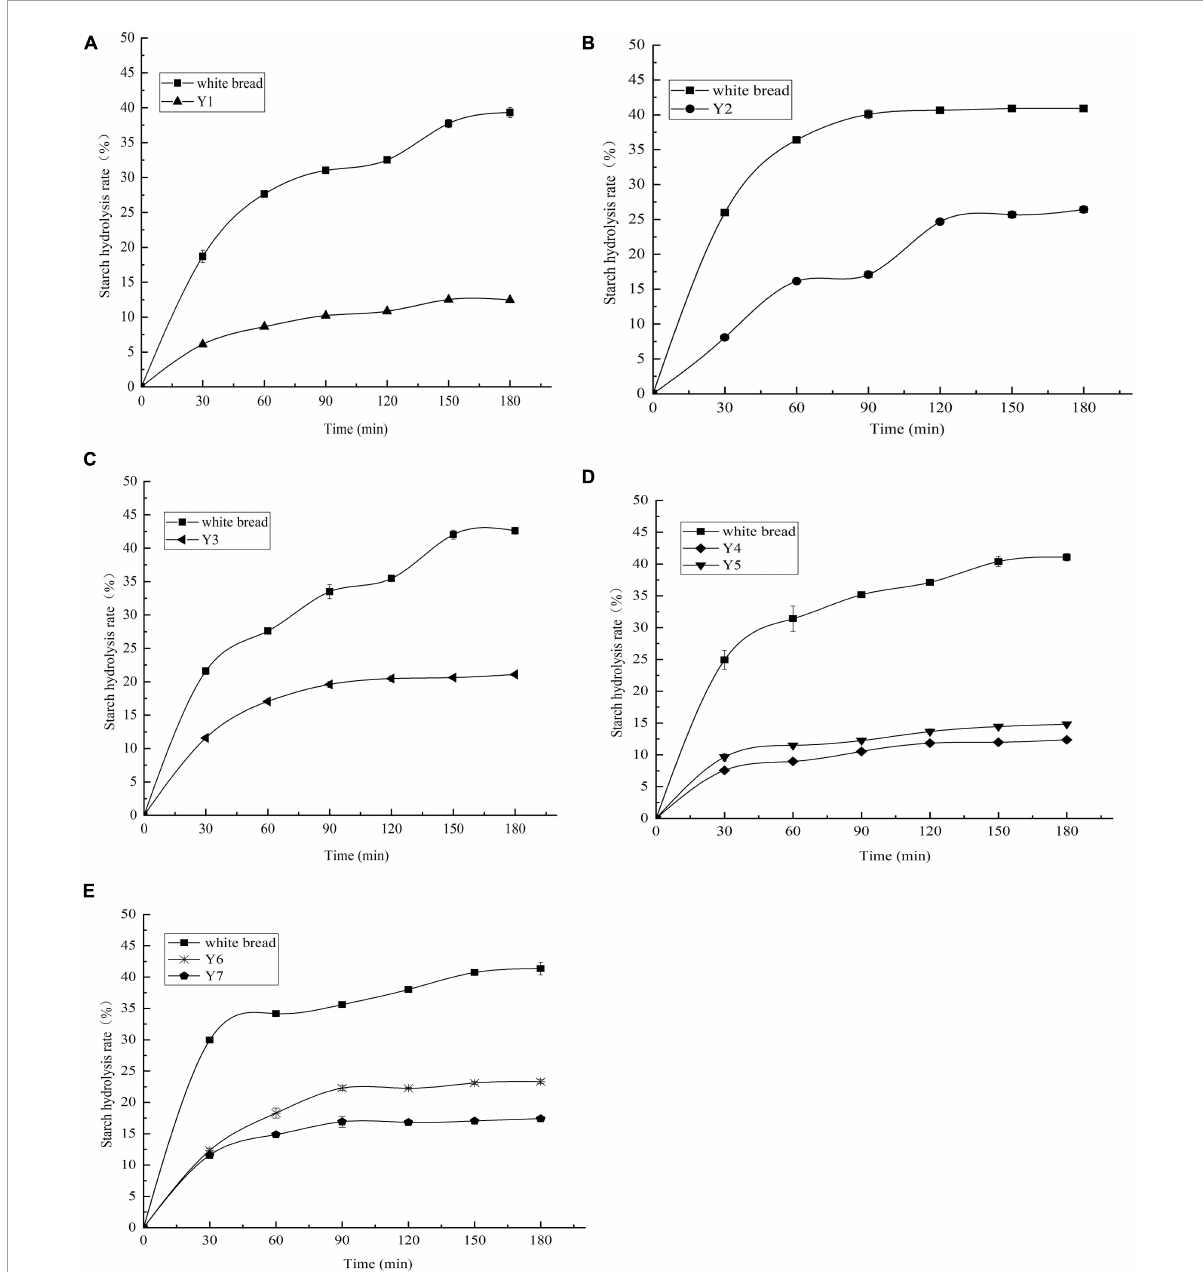
FIGURE3 (A–E) Starch hydrolysis curves of kidney beans and white bread. Y1, Weining white kidney bean; Y2, Biyun no.7; Y3, Qian yundou no.1; Y4, YJ009727A; Y5, Biyun1902; Y6, Biyun no.6; Y7, Biyun